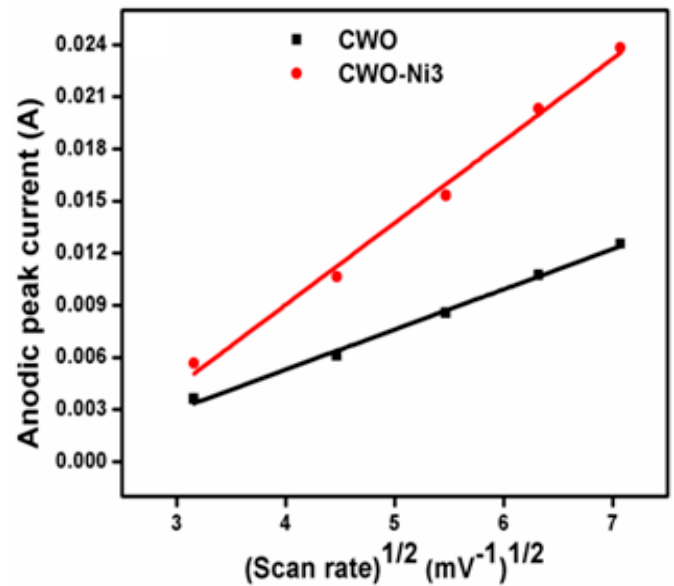
Figure 8. Linear dependence of the CV anodic peak current on the square root of the various scan rates for bare CWO and CWO–Ni3.